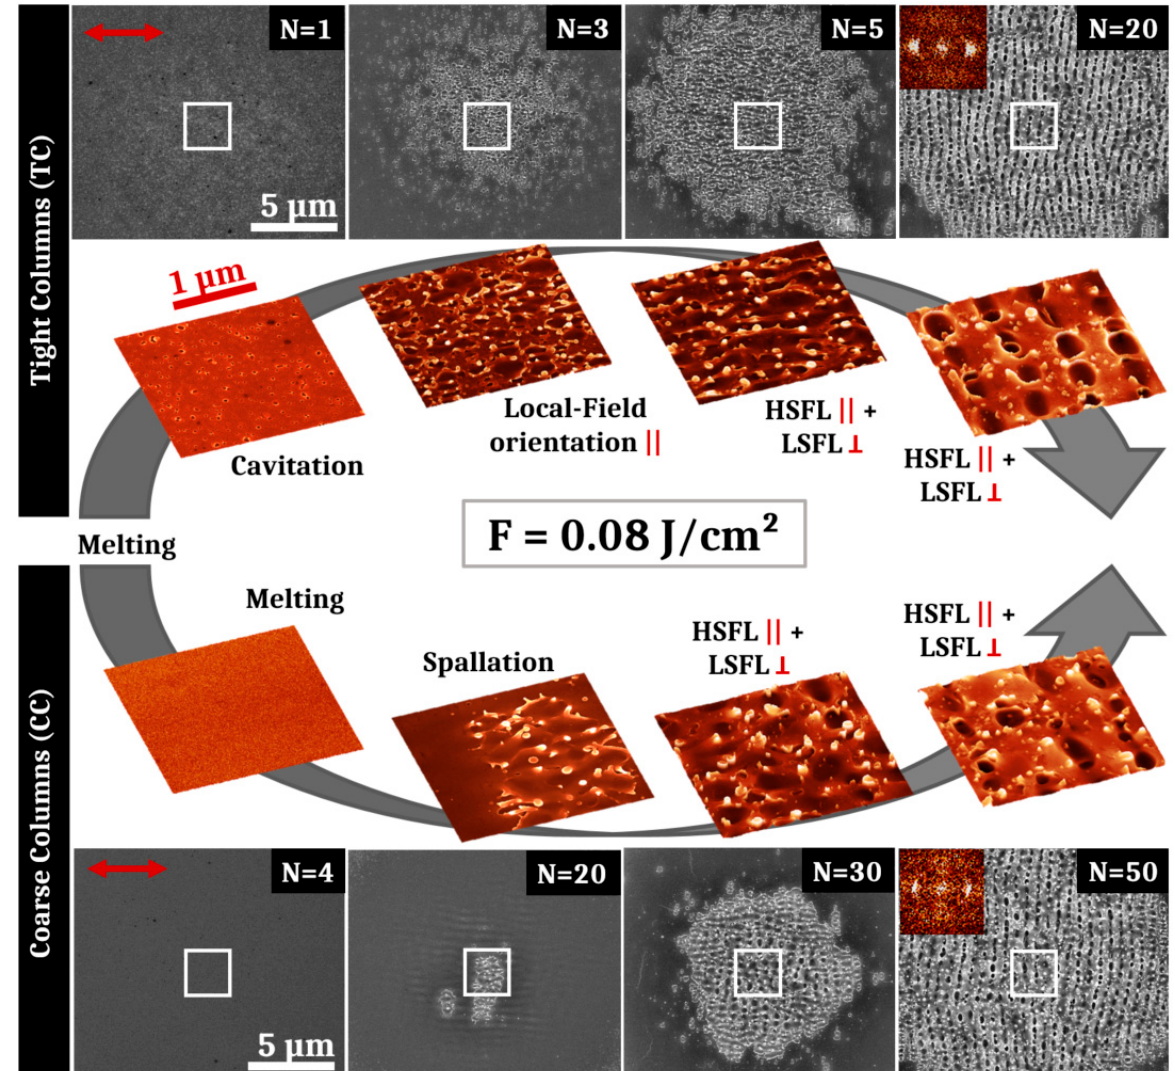
Figure 3. SEM and 3D-projections of SEM pictures of surface structures obtained after irradiation of the Tight Columns and the Coarse Columns samples with an average fluence of 0.12 J/cm 2 and different numbers of pulses. The evolution of structures is shown for different numbers of pulses. For the TC sample, successively appear disorganized filaments in- duced by spallation (N = 1), orientated filaments (N = 2), high spatial frequency laser-induced periodic surface structures (HSFL) parallel to the polarization intertwined between low spatial frequency laser-induced periodic surface structures (LSFL) perpendicular to the polarization (N = 5 and N =15). For the CC sample, successively appear residual cavitation bubbles (N = 2), LSFL (N = 3), horizontal HSFL and vertical LSFL (N = 4 and N = 15). The red arrow represents the electric field polarization. The symbols (||) and ( ꓕ ) respectively mean “parallel” and “perpendicular” to the polarization. 2D- Fourier transforms shown as insets support the presence of a crossed structure of HSFL and LSFL for the highest pulse numbers.